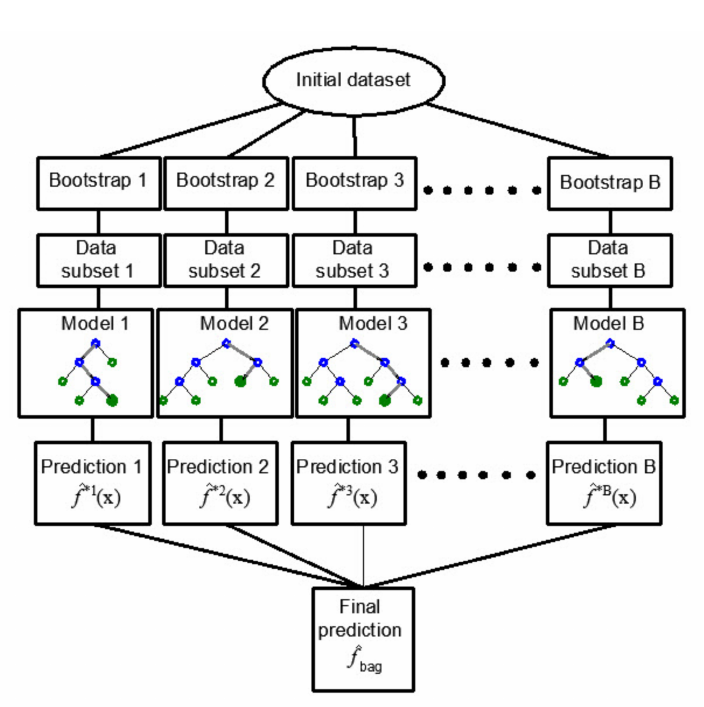
Figure 3. Bootstrap aggregation–Bagging in regression tree ensembles